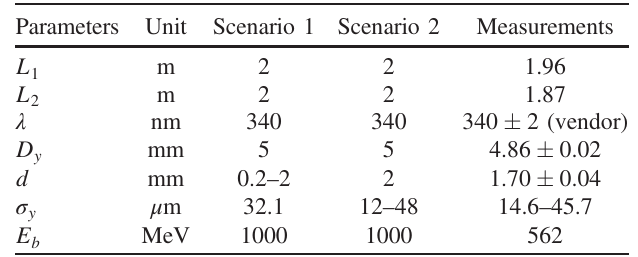
TABLE II. Design and measured parameters of the newly developed SRI system at the Duke storage ring and a set of key parameters used in simulations and measurements. The central wavelength of the bandpass filter is that specified by the